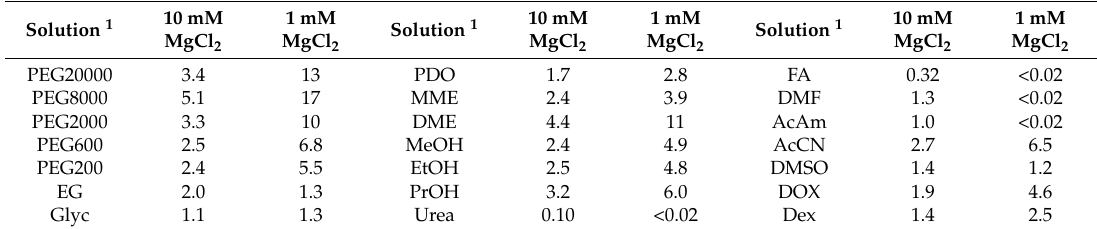
Table 1. Fold increase in the rate of the HH(S) -catalyzed turnover reaction in mixed solutions over the rate in the absence of organic